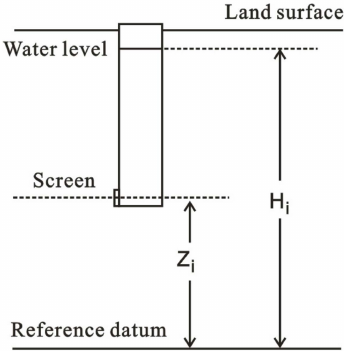
Figure 1. A schematic representation of a hydraulic head (H i ) and an elevation head (Z i ). Definitions are provided in Equation